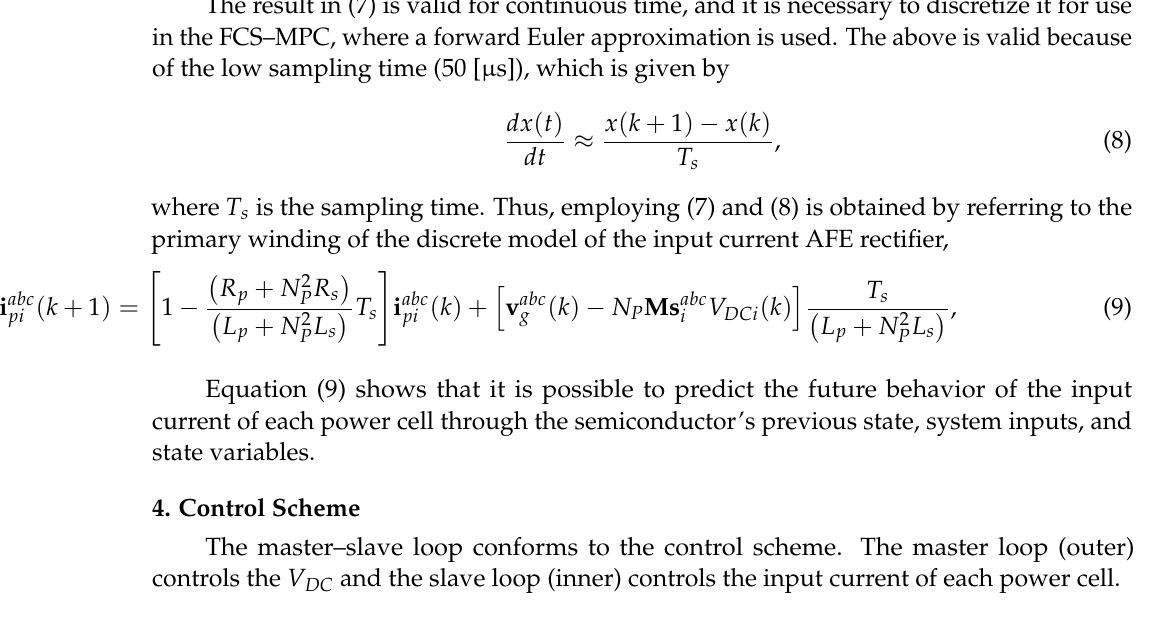
Figure 3. Power cell in multicell AFE rectifier. ( a ) Power cell. ( b ) Wye–wye transformer model. The input current model in each AFE rectifier, referred to as the primary winding of the transformer, is shown in (7). This model is valid for balanced AC voltage